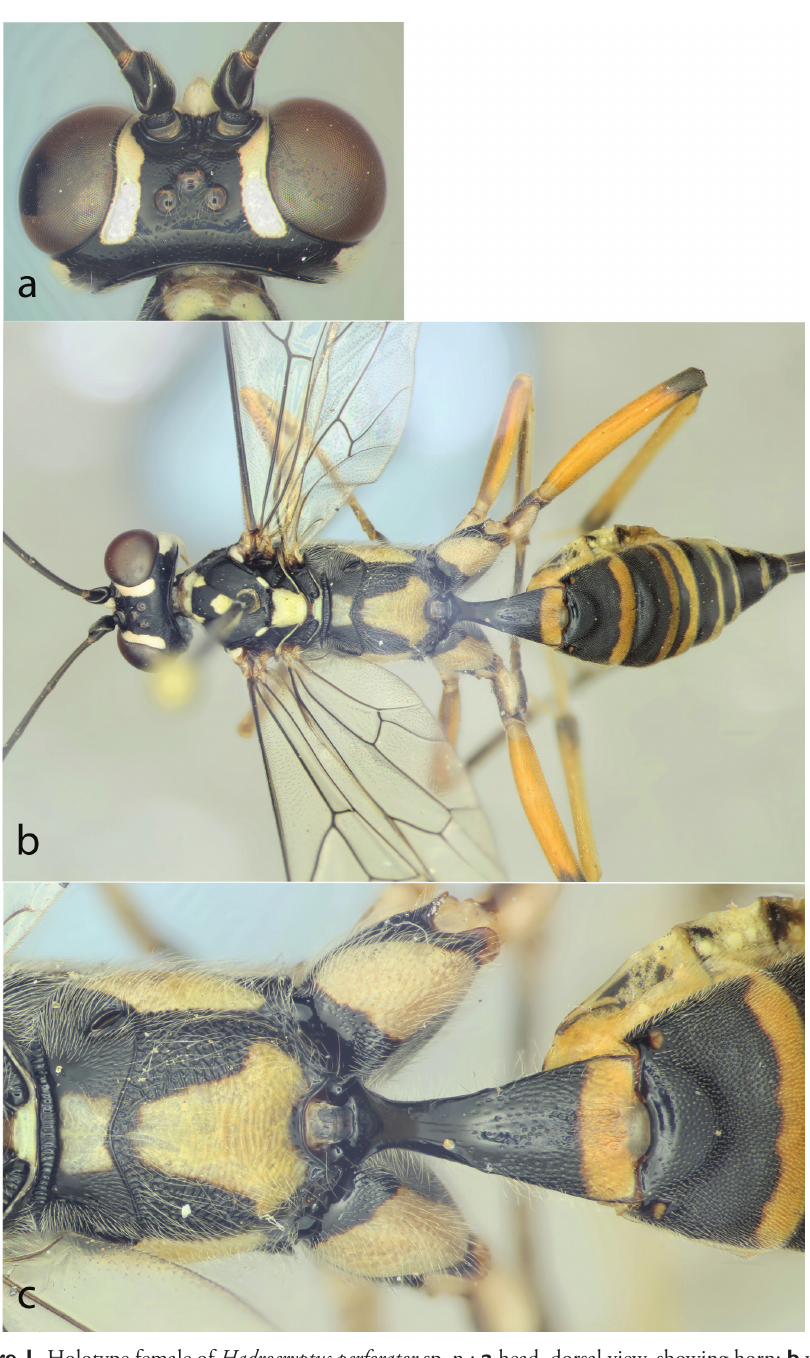
Figure 1. Holotype female of Hadrocryptus perforator sp. n.; a head, dorsal view, showing horn; b whole body, dorsal view; c propodeum and base of metasoma, dorsal